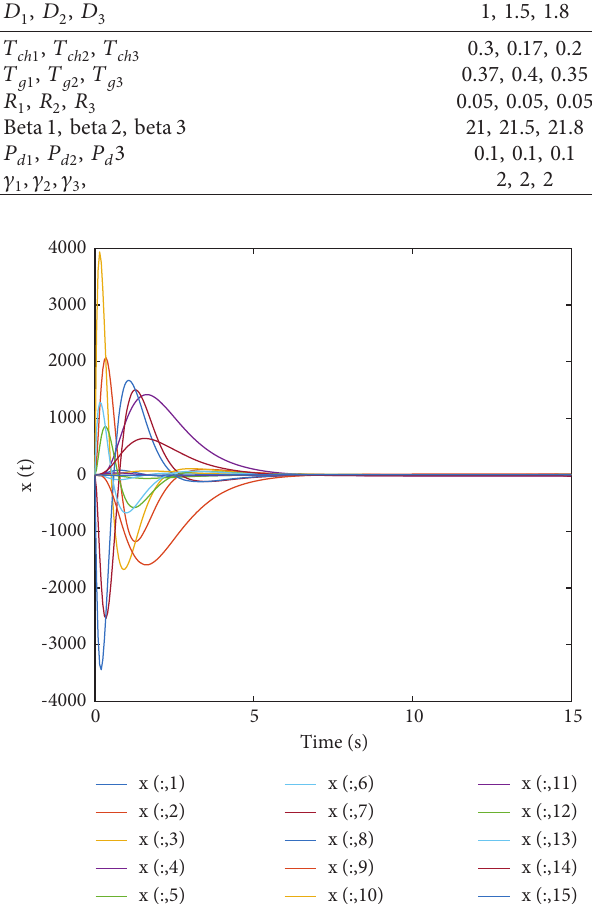
Figure 2: Frequency deviation of the power system.